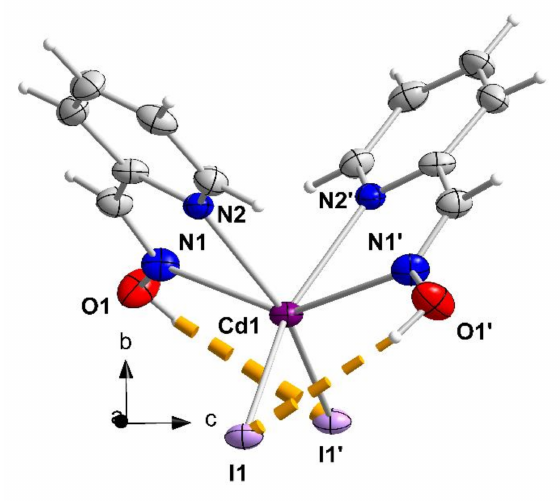
Figure 6. The structure of the [CdI 2 (2paoH) 2 ] molecule that is present in 1 . The thermal ellipsoids are presented at the 50% probability level. Only the metal, the donor atoms and the oxime oxygen atoms are numbered. The dashed lines indicate intramolecular hydrogen bonds. Symmetry operation: ( (cid:48) ) = x , y , − z + 1/2.